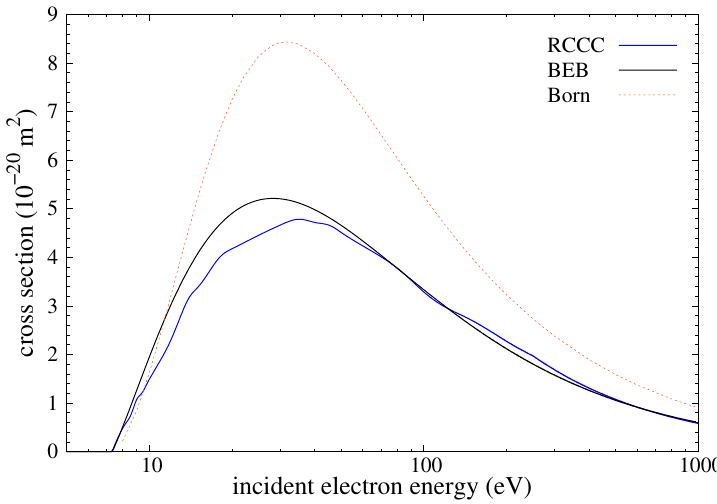
Figure 19. RCCC DI from the 5 p 2 3 P 0 ground state compared with the BEB results of Kim and Stone [16] and the Born results of Bartlett and Stelbovics